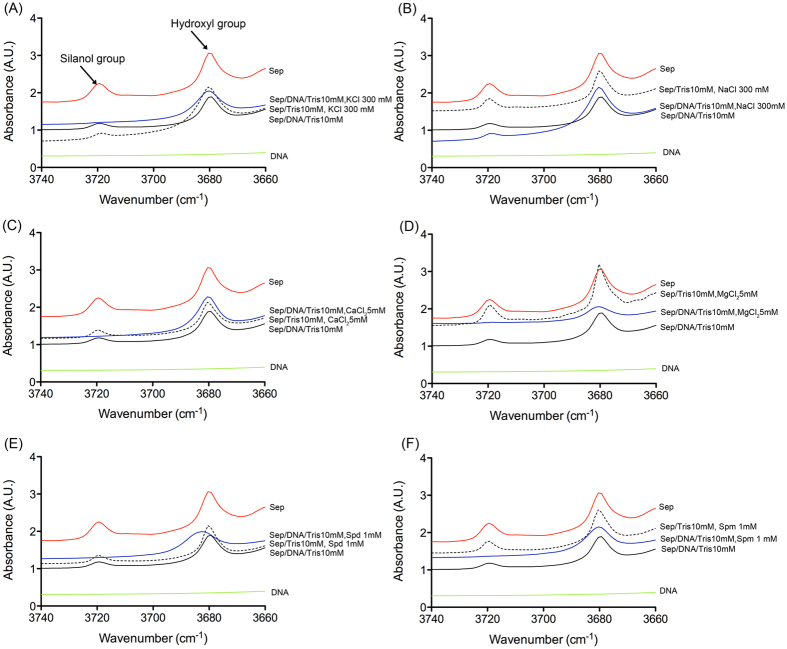
FTIR spectra of sepiolite and the Sep/DNA bionanocomposite prepared in 10 mM Tris-HCl pH = 7.5 compared to Sep/DNA bionanocomposites prepared in the presence of monovalent (A: NaCl, B: KCl), divalent (C: CaCl2, D: MgCl2), trivalent (E: spermidine) and tetravalent (F: spermine) cations.